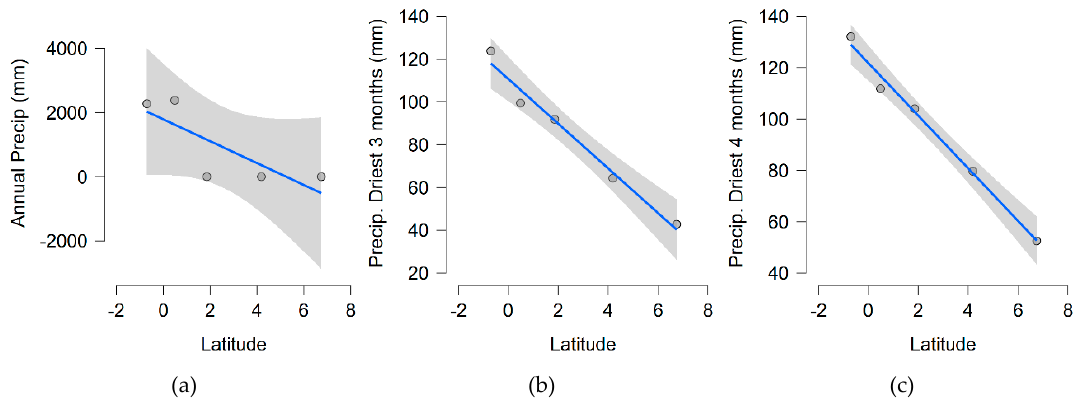
Figure 8. There is a dependency of annual precipitation ( a ) as well as precipitation during driest 4 months ( b ) and 3 months (c) , on the latitude. Data: Hdh. Hanimaadhoo, Male, L. Kadhdhoo, Gdh.Kaadedhoo and S.Gan. 95% confidence bands are shown. Pearsons r values for annual precipitation, 3 and 4 month dry periods are − 0.798 ( p = 0.105, not significant), − 0.989 ( p < 0.001) and 0.995 ( p < 0.001), respectively.